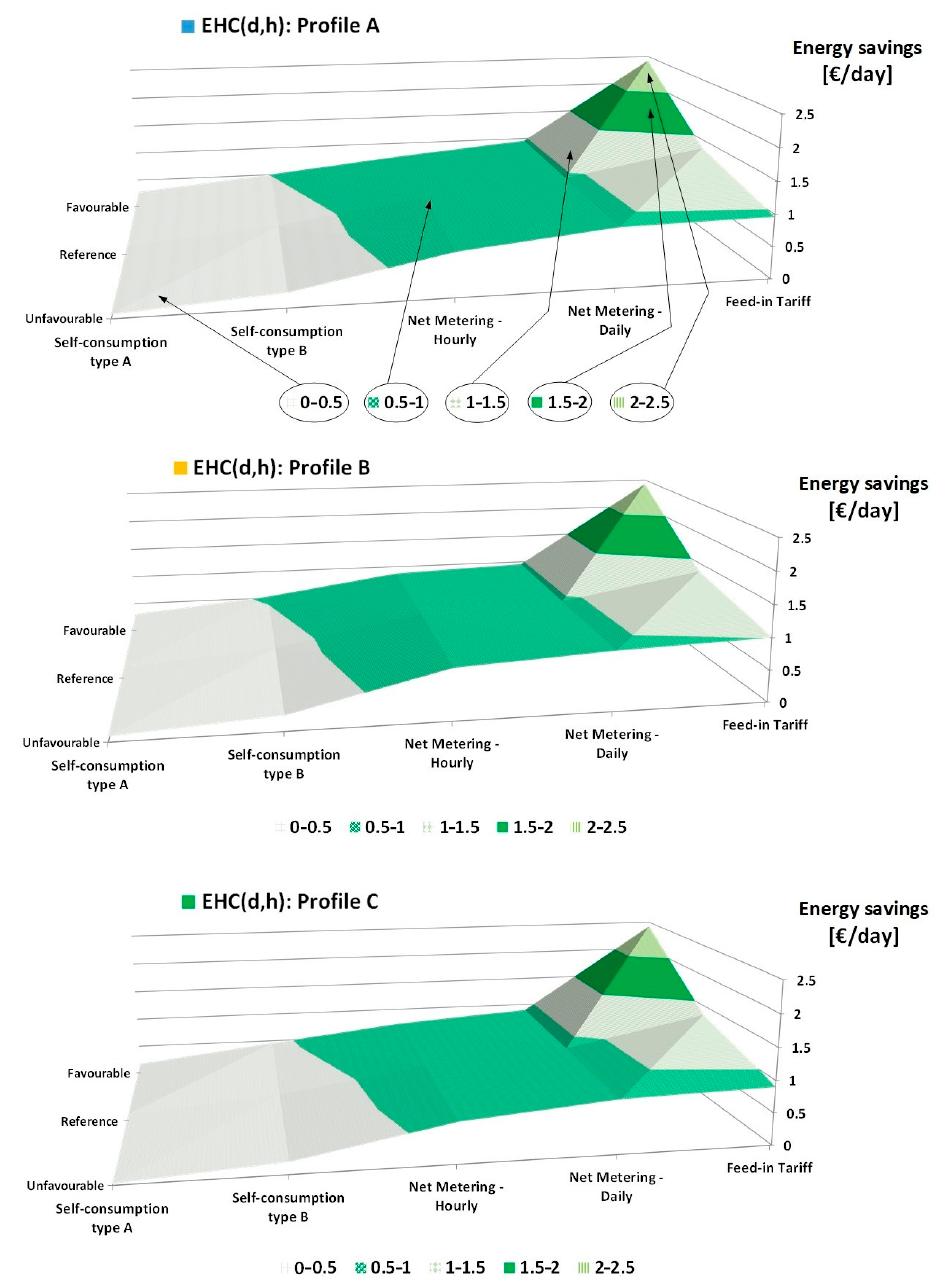
Figure 12. Energy economic results of a single prosumer with ESS under different types of consumption profiles. Source: self-elaboration.